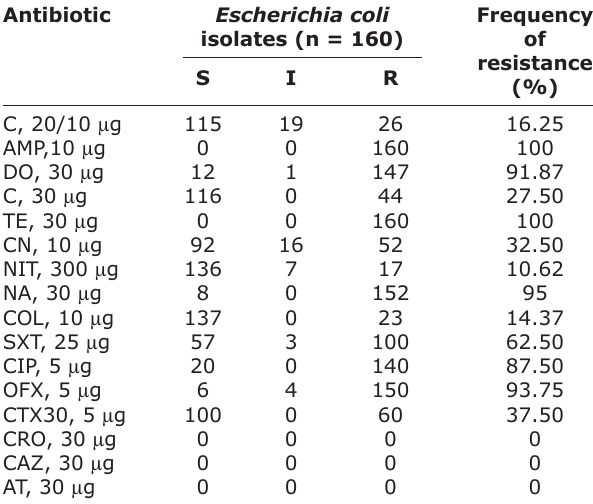
Table-1: Antibiogram results for 160 APEC